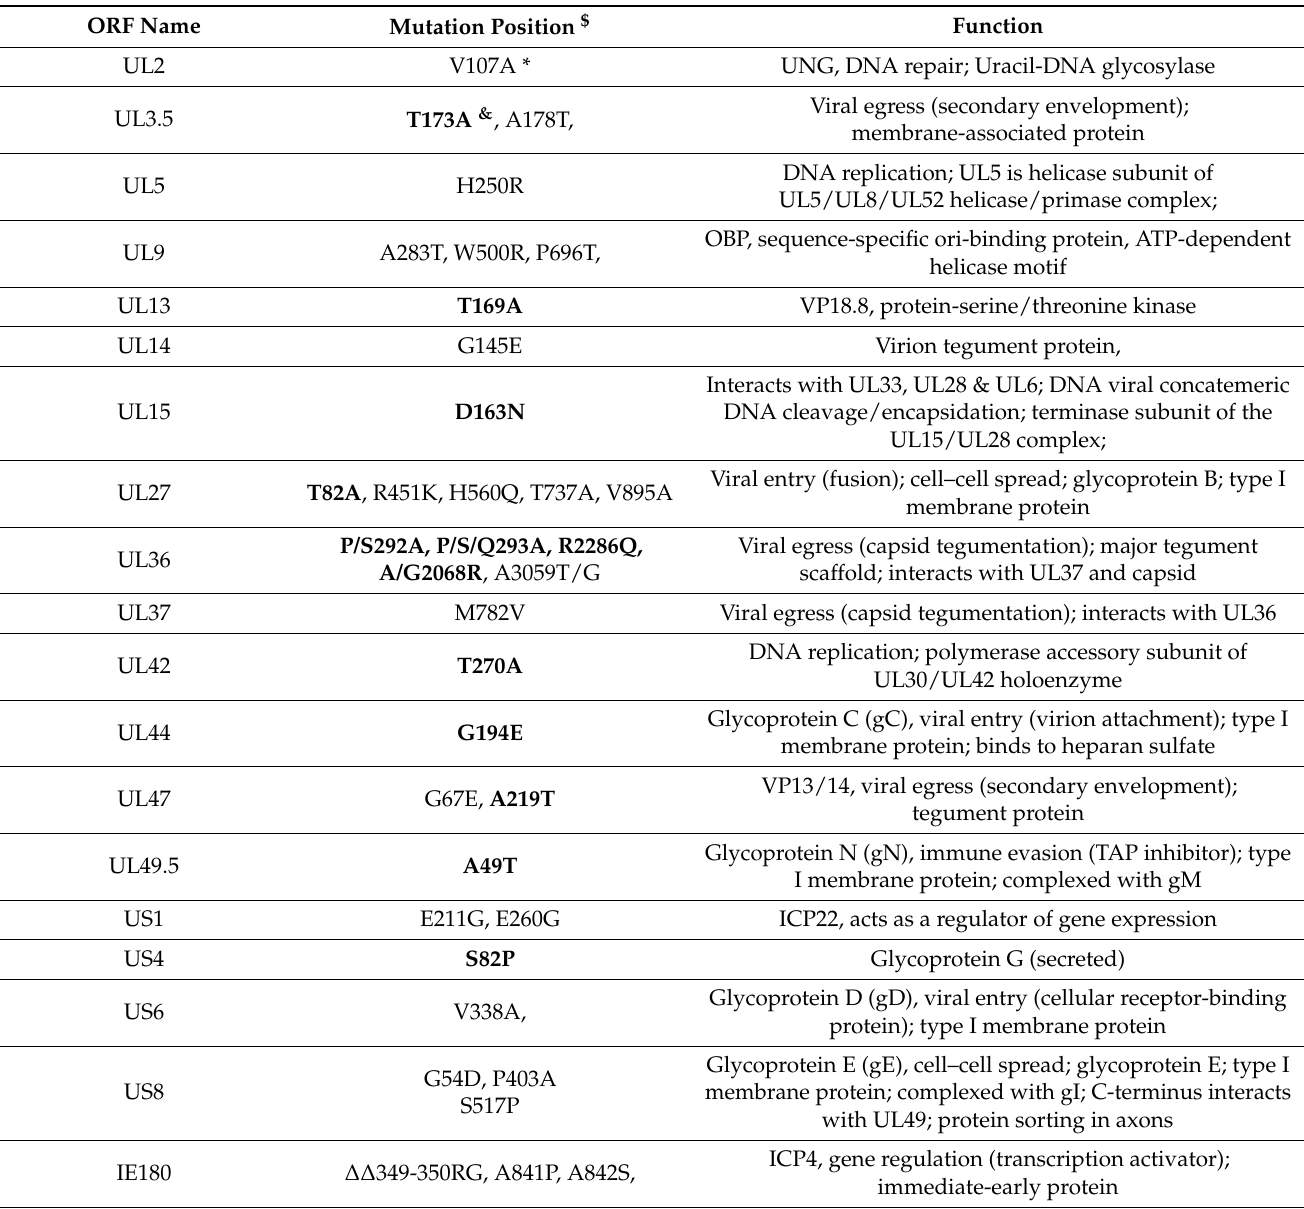
*: The mutation sites listed in the table indicate that certain amino acid residues of every PRV strain isolated after 2011 except HuB1/CHN2017 are collectively different from the classic Chinese PRV strains Ea/Fa and SC, which distinguish the novel PRV variants from the classic Chinese PRV strains (Ea, Fa, and SC). & : The mutation sites with bold letters indicate that certain amino acid residues of every PRV strain isolated after 2011 except HuB1/CHN2017 are collectively different from the classic Chinese PRV strains Ea, Fa, and SC and all EU/US strains. $ : Each amino acid residue number is the codon number in the corresponding ORF of reference genome Ea.